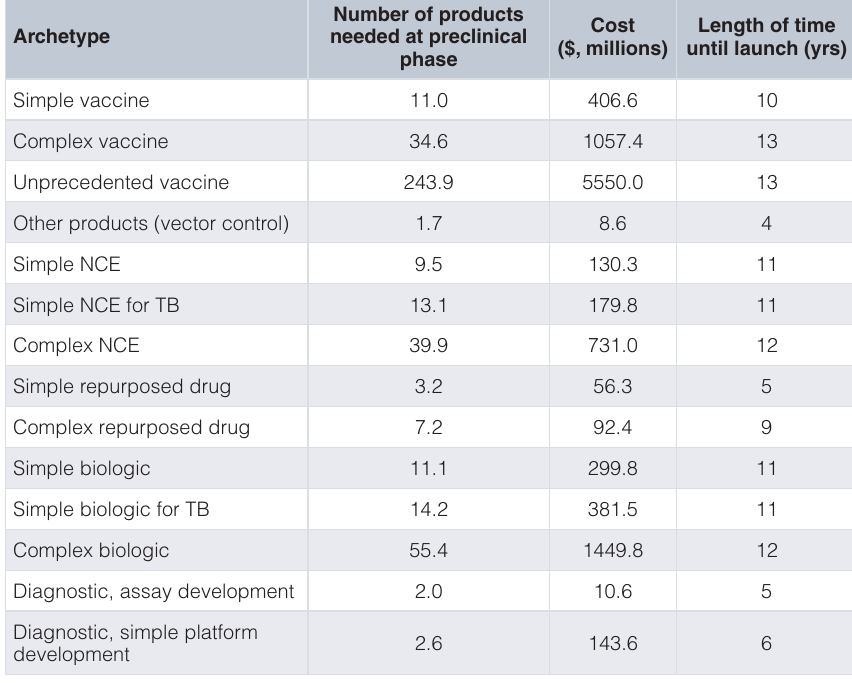
Table 10. Estimates of the number of product candidates needed at preclinical phase, development cost, and length of time until launch for to launch one product, by archetype, assuming pipeline is empty.